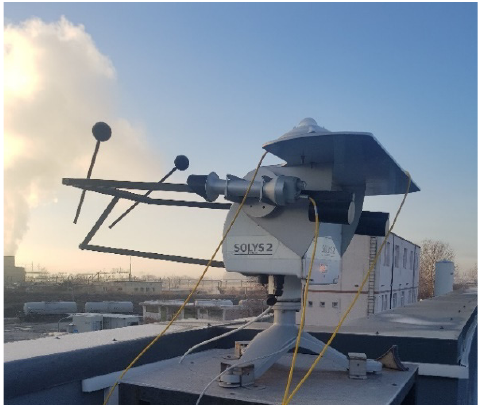
Figure 20. Solys2 solar detection station.